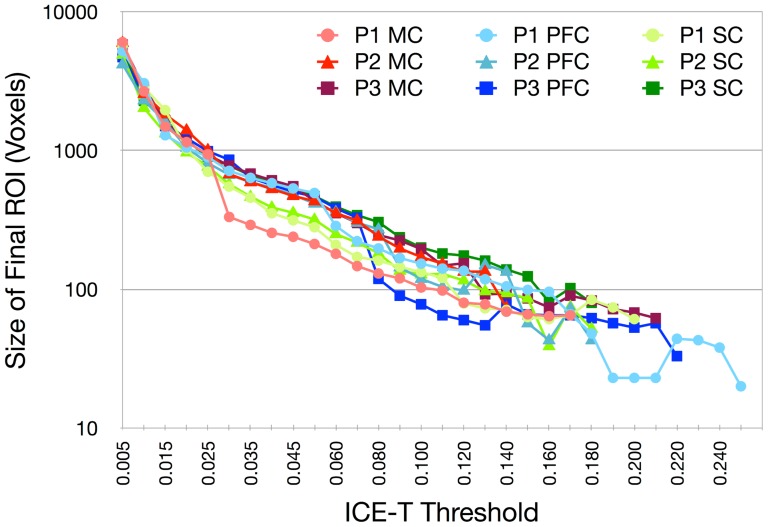
The impact of the ICE-Tthreshold parameter.Curves show the parameter's effect upon the size of ICE-T_ROII with the ICE-Tstreams parameter fixed at 20 streamlines, shown for each of the three ROIs (MC, PFC and SC) in each of the three ex-vivo datasets (P1, P2 and P3).